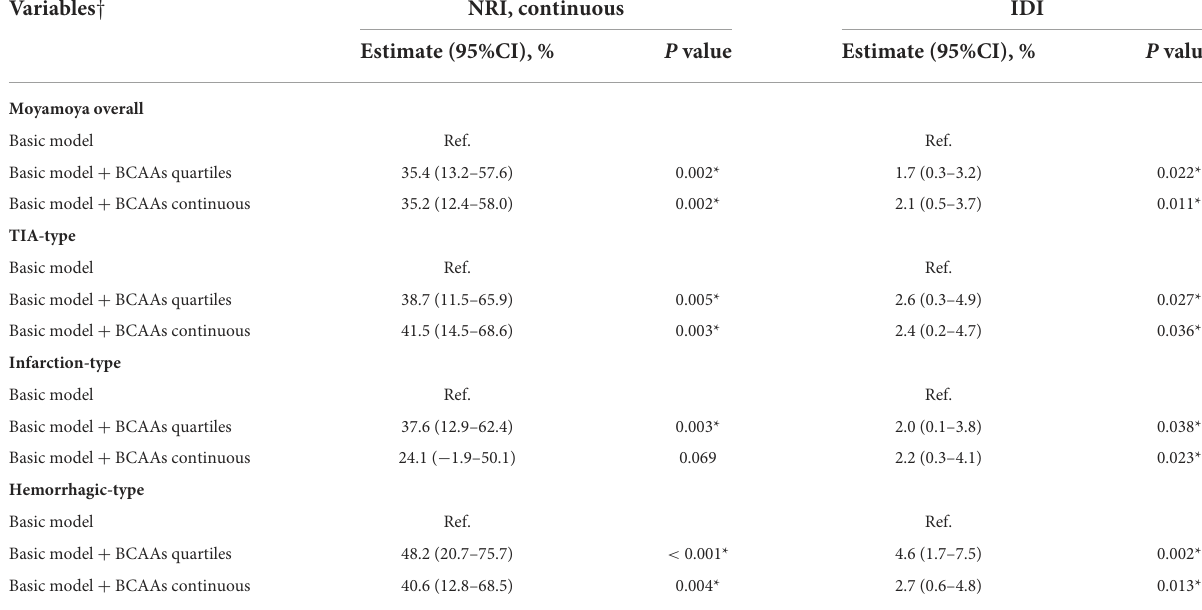
TABLE 3 Performance of models with BCAAs to predict the risk of MMD and its